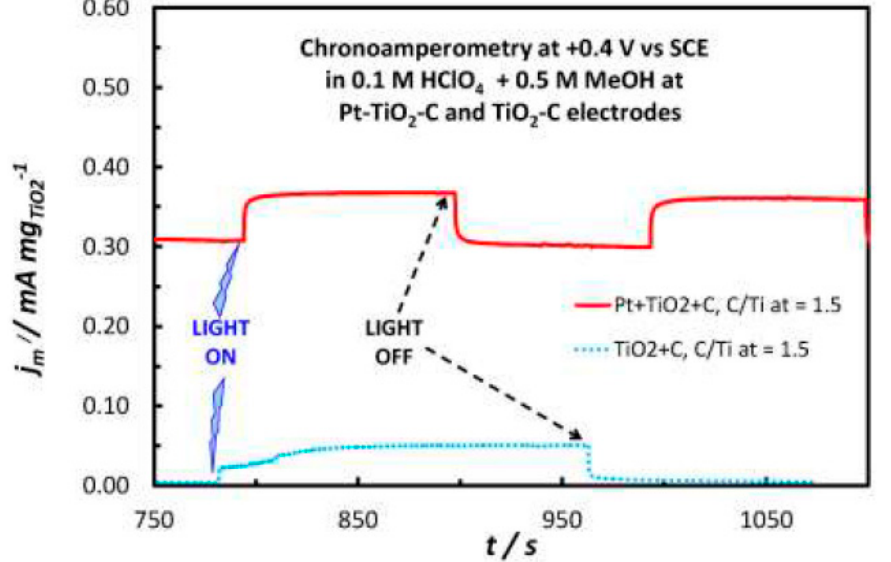
Figure 7. Constant potential chronoamperometry (CA), recorded in 0.1 M HClO 4 + 0.5 M MeOH solutions at + 0.4 V vs. SCE, at Pt-TiO 2 -C and TiO 2 -C electrodes (with a C ÷ Ti atom ratio of 1.5), in the dark and under UV light illumination. Current densities, j m/ , are per mg of TiO 2 .